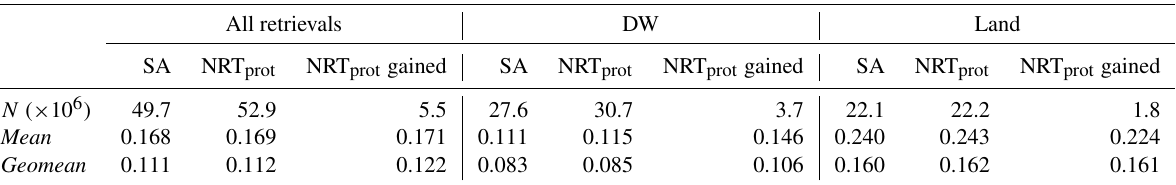
Table 1. Additional statistics for the data presented in Figs. 2 and 3 (statistics for FIRSTLOOK not shown). NRT prot gained stands for the prototype NRT retrievals that do not have a matching SA equivalent; geomean stands for the geometric mean AOD.